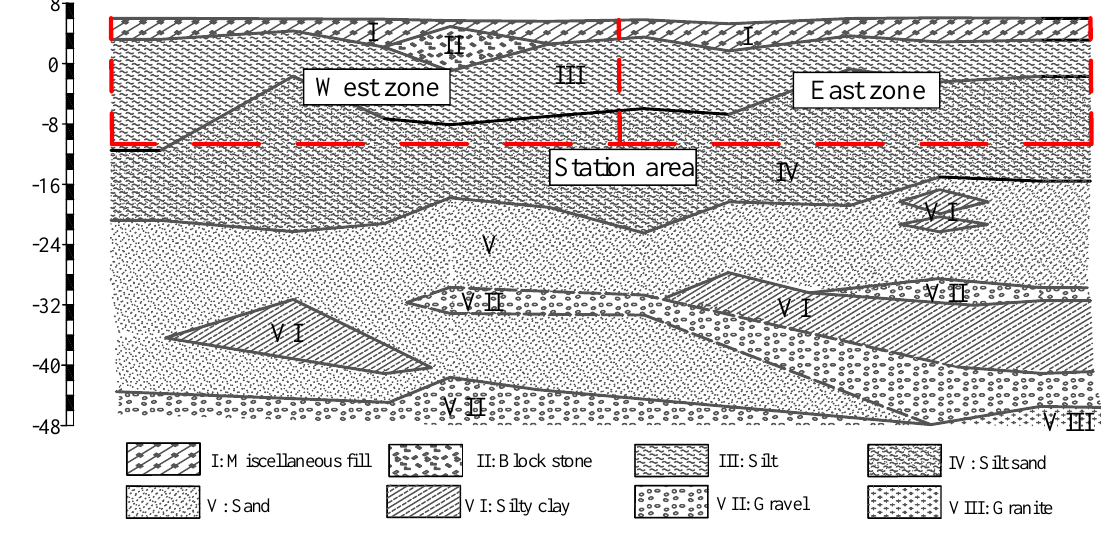
Figure 2. Geological profile of the Shuibu Metro Station. Table 1. Hydraulic parameters in geological exploration